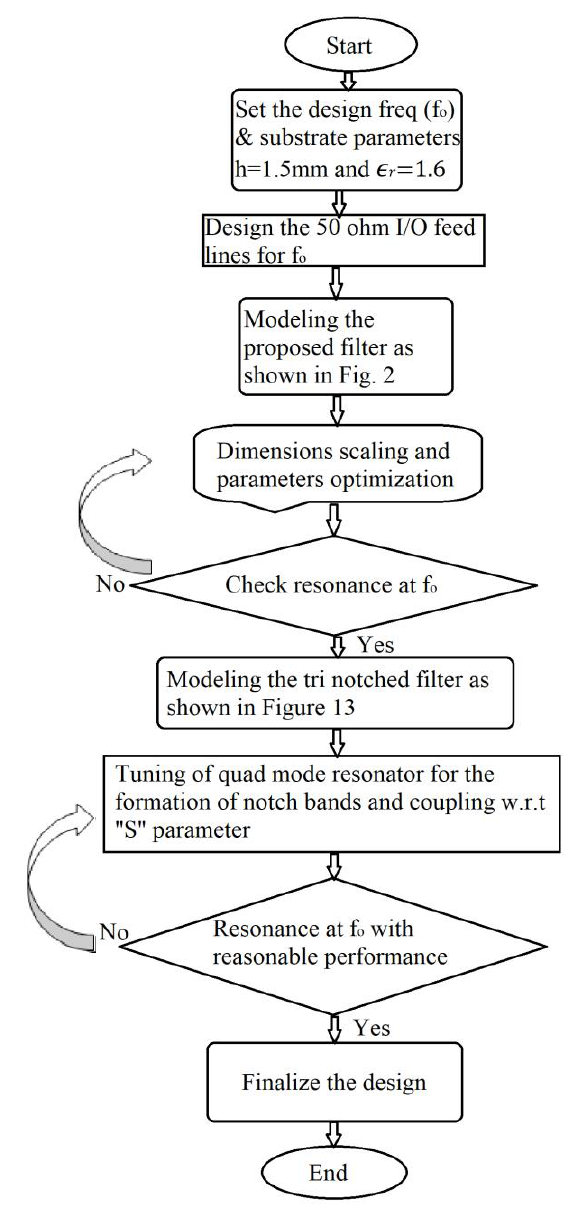
Figure 1. Design flow chart.